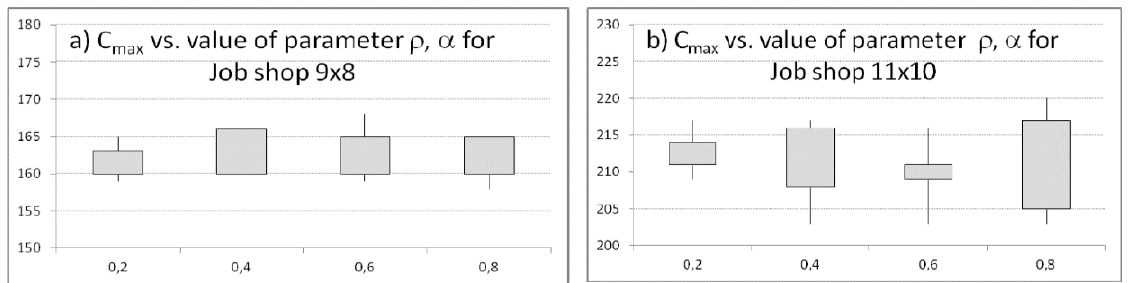
Figure 5. The C max of the best basic schedules achieved by the ACO for different values of parameter α = ρ . Then, the simulations are continued for the number of ants, K = {15}, iteration size, E = {20}, parameter α = ρ = { 0.2 } and changing values of parameter q 0 which decides abot exploration or exploatation selection by an ant, q 0 = { 0.3, 0.4, 0.5, 0.6 } . Observing average values of C max and the best schedules achieved (Figure 6) the following conclu- sion can be drawn that the lower values of parameter q 0 are, the higer chances of achiev- ing a better solution are. The average quality of population does not increase with the parameter values for scheduling problems (9 × 8) and (11 × 10) (Figure 6a,b).